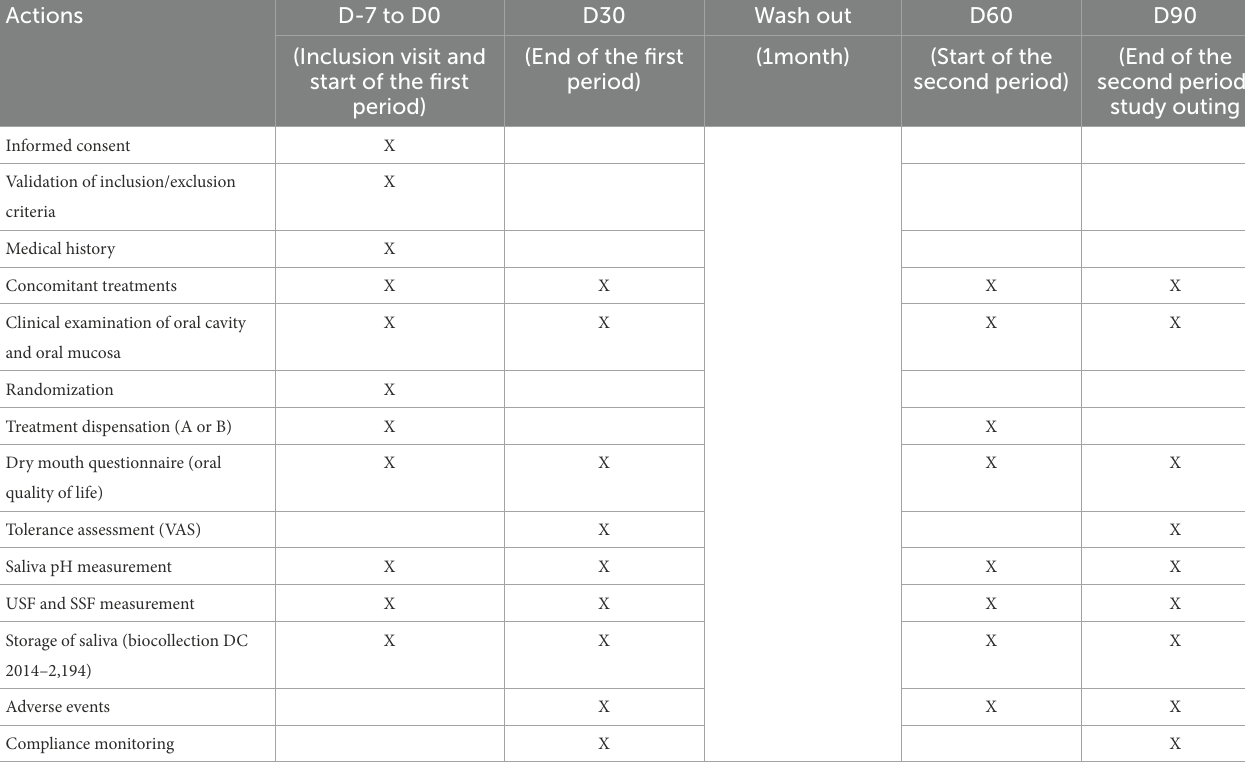
TABLE 1 Elements collected during the different